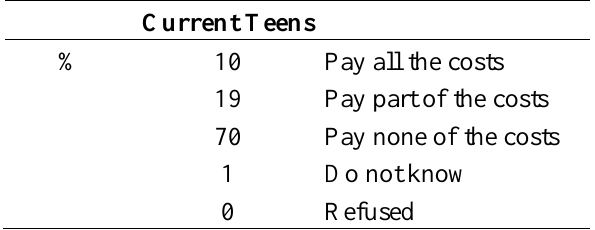
Table A9. Do you, yourself, pay all of the bills for your cell phone… do you pay only part of the costs… or do you pay none of the cell phone costs? ( Based on teen cell users [ N = 625] ).